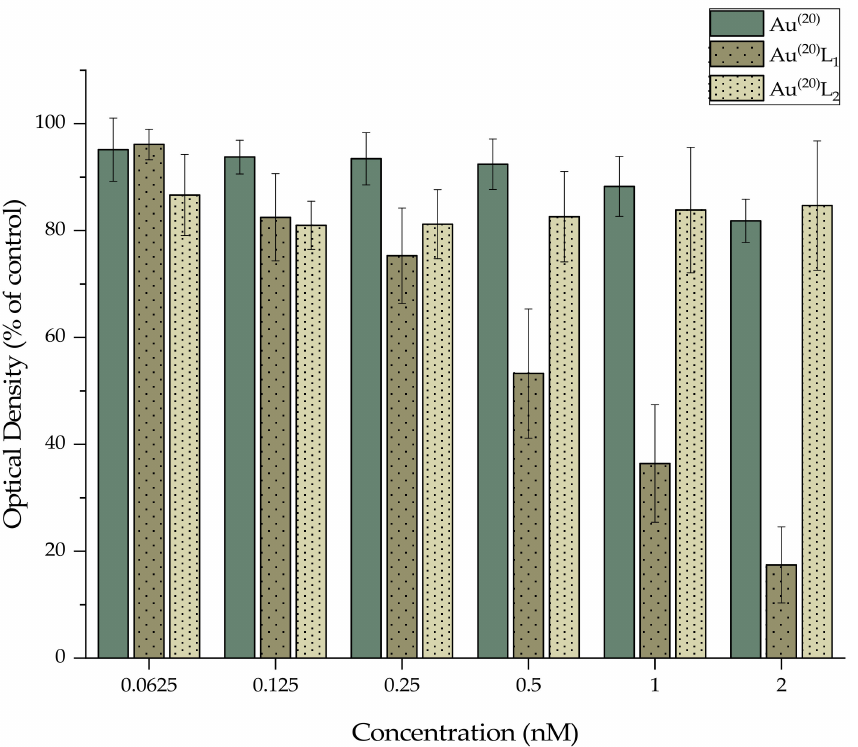
Figure 6. MTT assay of 4T1 cells treated with different concentrations of Au (20) , Au (20) L1 and Au (20)